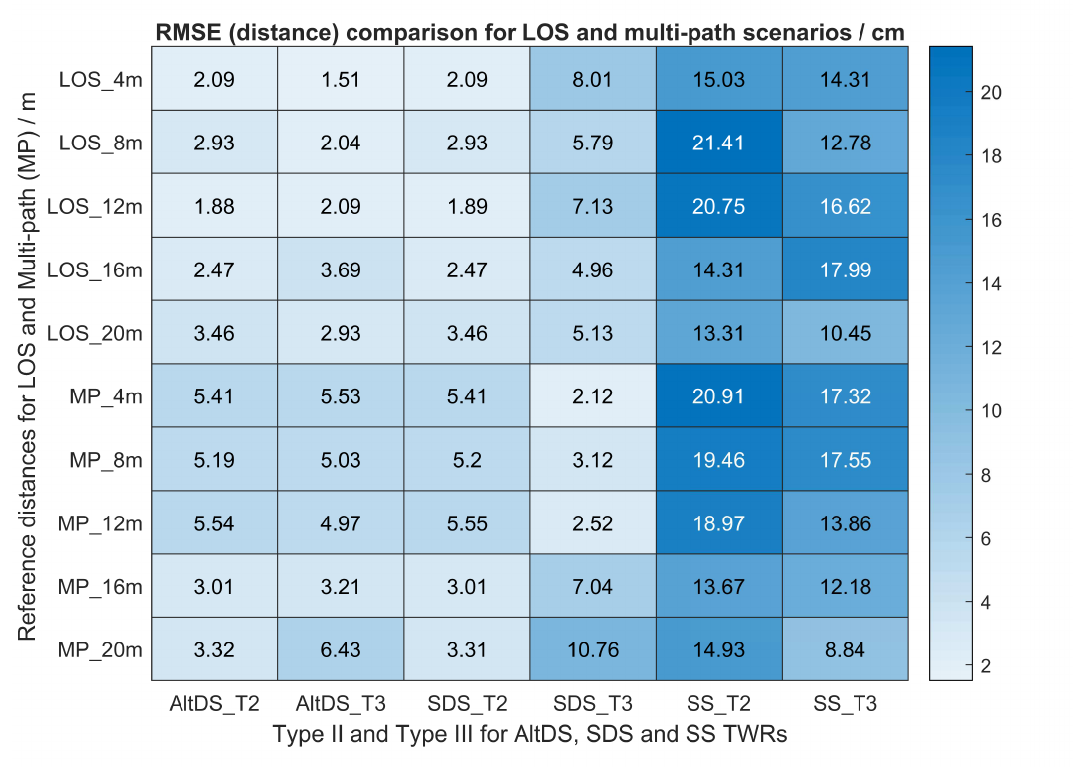
Figure 10. Measured distance error comparison of Types II and III for three TWRs evaluated in different locations in LOS and multipath